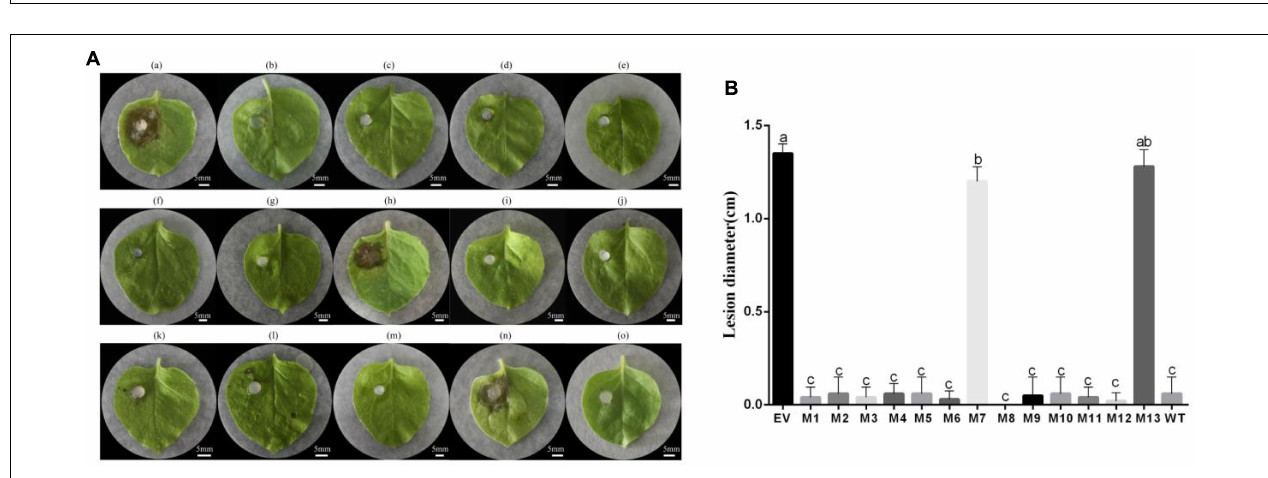
FIGURE 5 | The transient expression vector of subtilisin mutants induced resistance in N. benthamiana against B. cinerea . (A) (a)–(o), respectively, are representative phenotypes of disease caused by B. cinerea in leaves of N. benthamiana expressing pK7WG2D control (EV), subtilisin-p1 mutants (M1), subtilisin-p2 mutants (M2), subtilisin-p3 mutants (M3), subtilisin-p4 mutants (M4), subtilisin-p5 mutants (M5), subtilisin-p6 mutants (M6), subtilisin-p7 mutants (M7), subtilisin-p8 mutants (M8), subtilisin-p9 mutants (M9), subtilisin-p10 mutants (M10), subtilisin-p11 mutants (M11), subtilisin-p12 mutants (M12), subtilisin-p13 mutants (M13), and wild-type subtilisin (WT). Photographs were taken at 3 days after inoculation with B. cinerea . Experiments were carried out with five leaves per treatment. (B) Lesion diameter caused by B. cinerea was measured in N. benthamiana leaves expressing EV, M1, M2, M3, M4, M5, M6, M7, M8, M9, M10, M11, M12, M13, and WT. Data presented in (B) are the means ± SD of lesion diameter of five leaves. Columns with different letters indicate significant differences according to Duncan’s multiple tests ( p < 0.05).